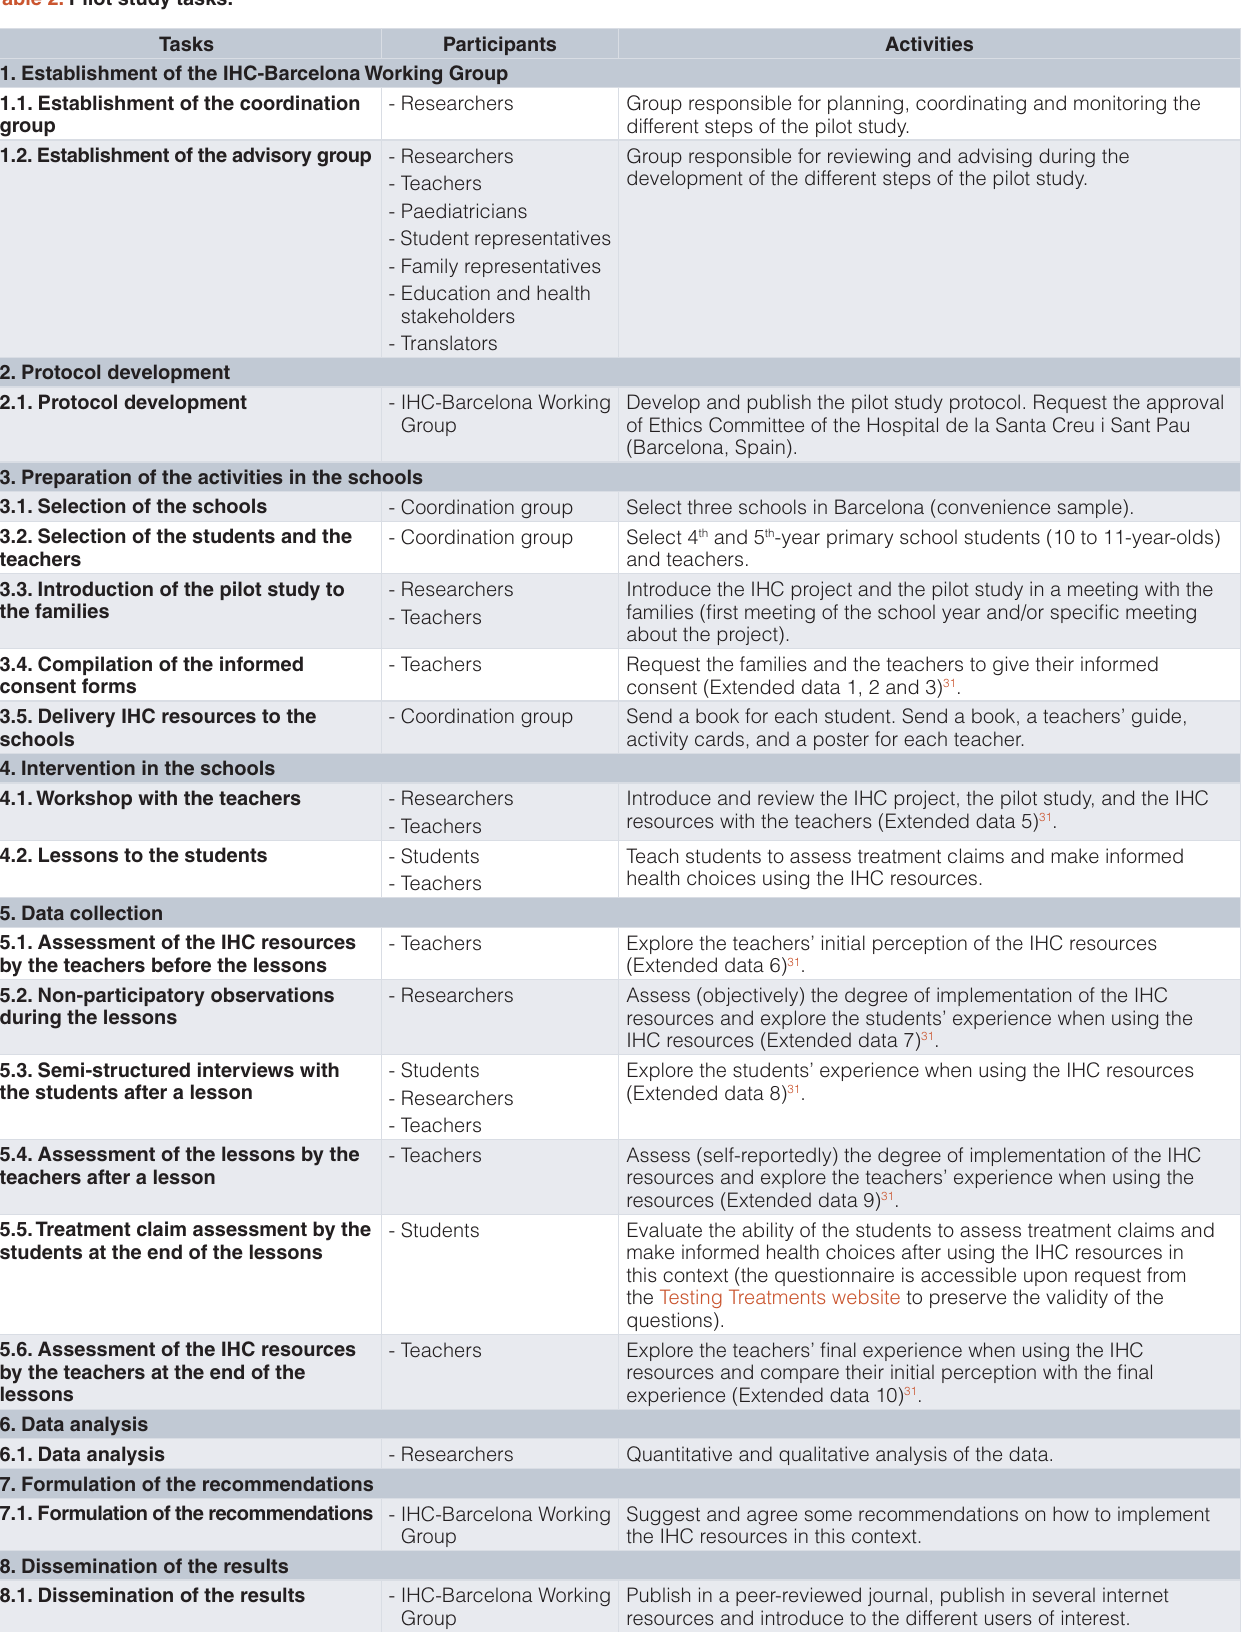
Table 2. Pilot study